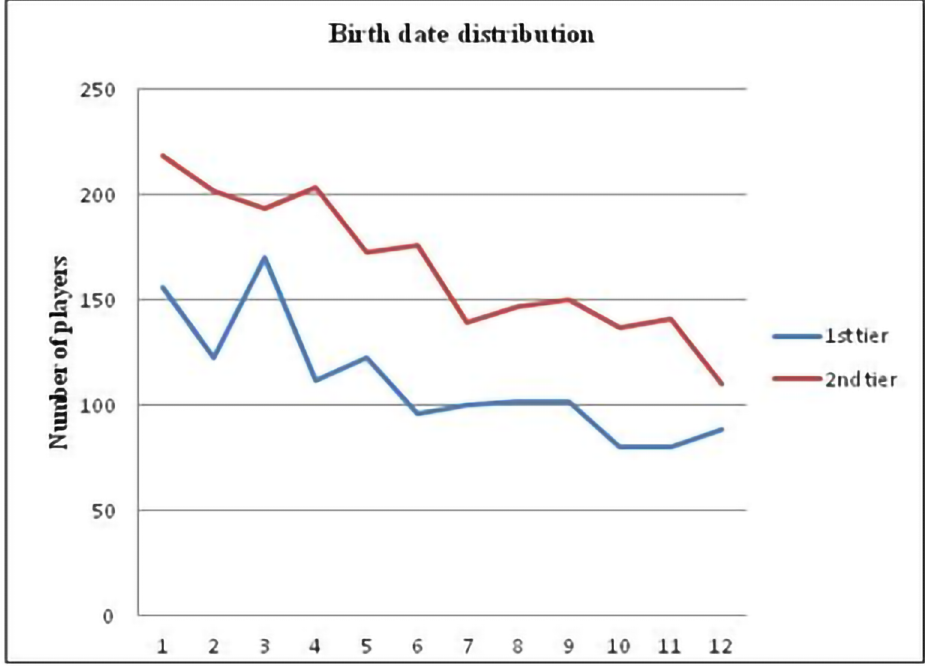
Fig 1. Soccer players’ birth dates monthly distributions for first- and second-tiers of the top five European leagues.